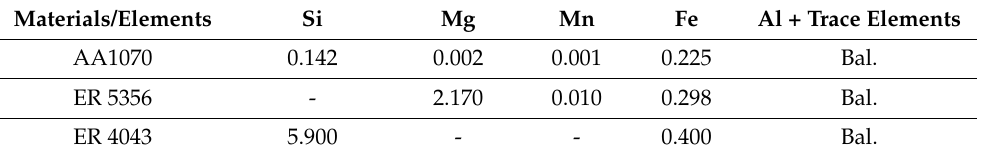
Table 1. Material compositions (wt %) measured by an optical emission spectrometer. Materials/Elements